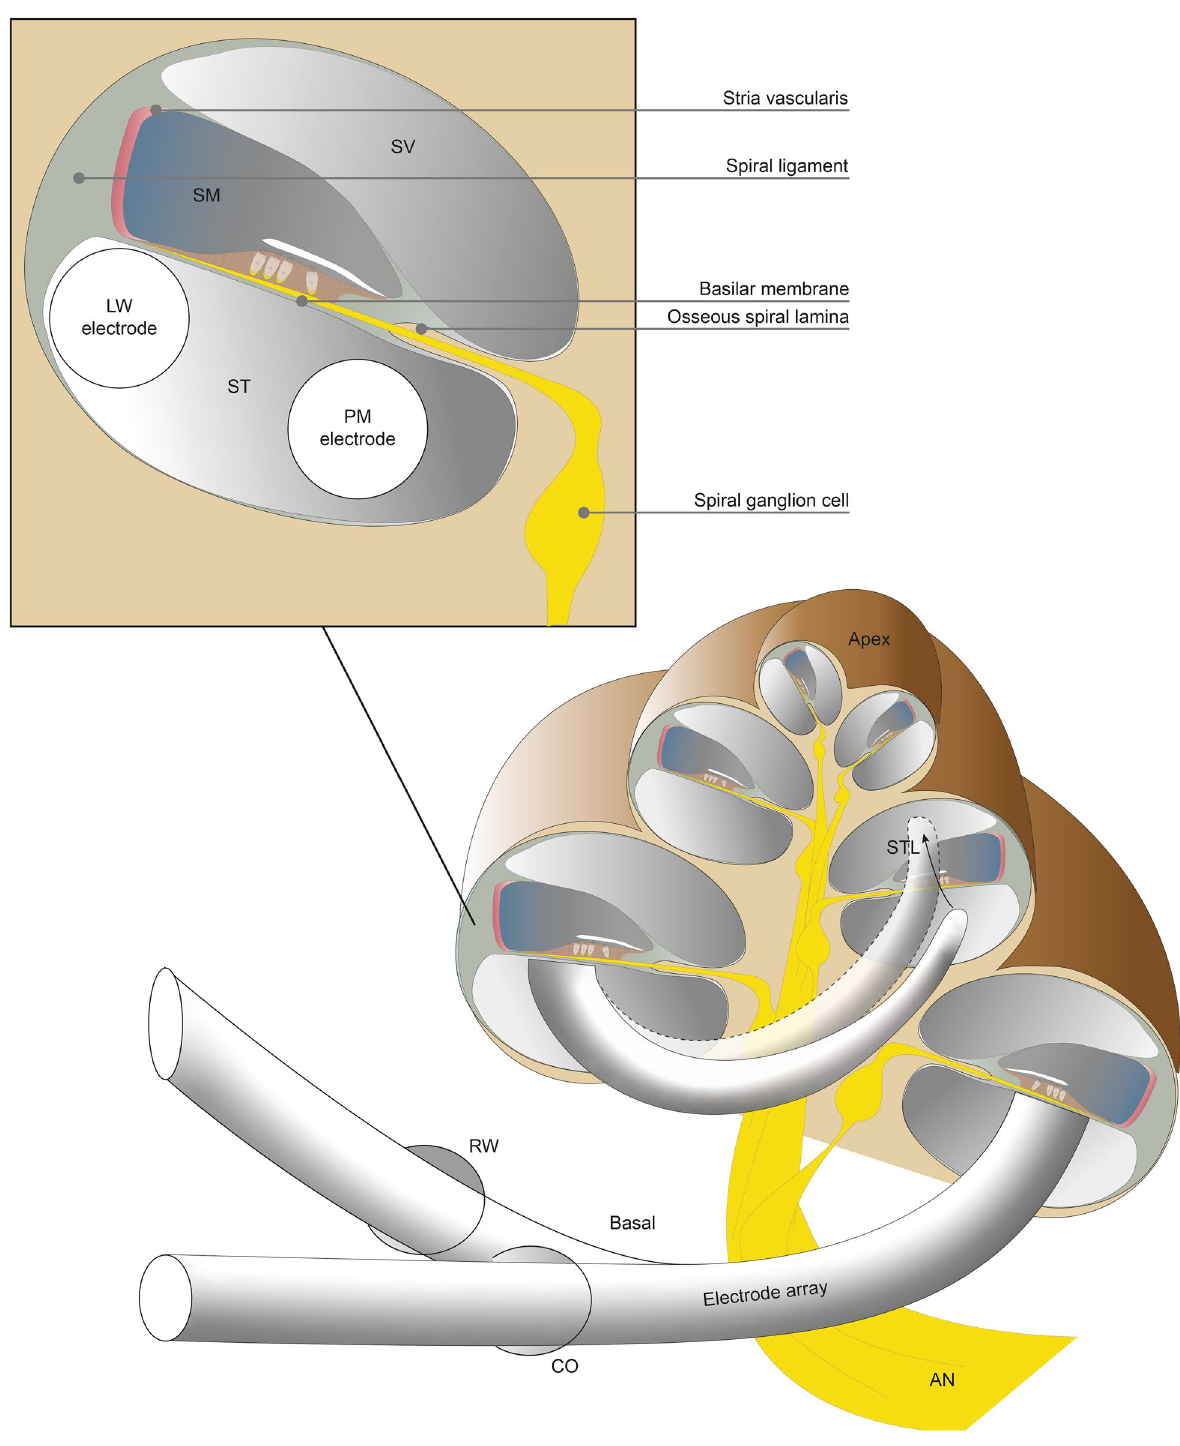
Figure 1. A cross section of the cochlea is depicted with an implanted electrode array. The electrode array is implanted in the scala tympani, using either the round window or a small hole in the cochlea (cochleostomy) for entry. The array follows the spiral curvature of the cochlea from the base of the cochlea towards the apex. Arrays usually reach at least around one turn and half, depending on the exact length of the array. Perimodiolar arrays are positioned more towards the spiral ganglion cells of the auditory nerve and beneath the osseous spiral lamina, and in contrast, lateral wall arrays are positioned laterally towards spiral ligament and beneath basilar membrane. In some cases the array can translocate during insertion (i.e. STL) from ST to SV or SM, which is detrimental for the structures that lie in between. RW round window, CO cochleostomy, AN auditory nerve, STL scalar translocation, ST scala tympani, SV scala vestibule, SM scala media, LW lateral wall, PM